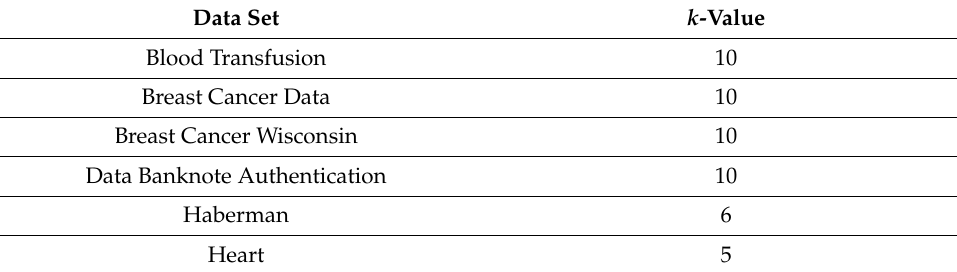
Table 5. Number of folds applied in the cross-validation process.